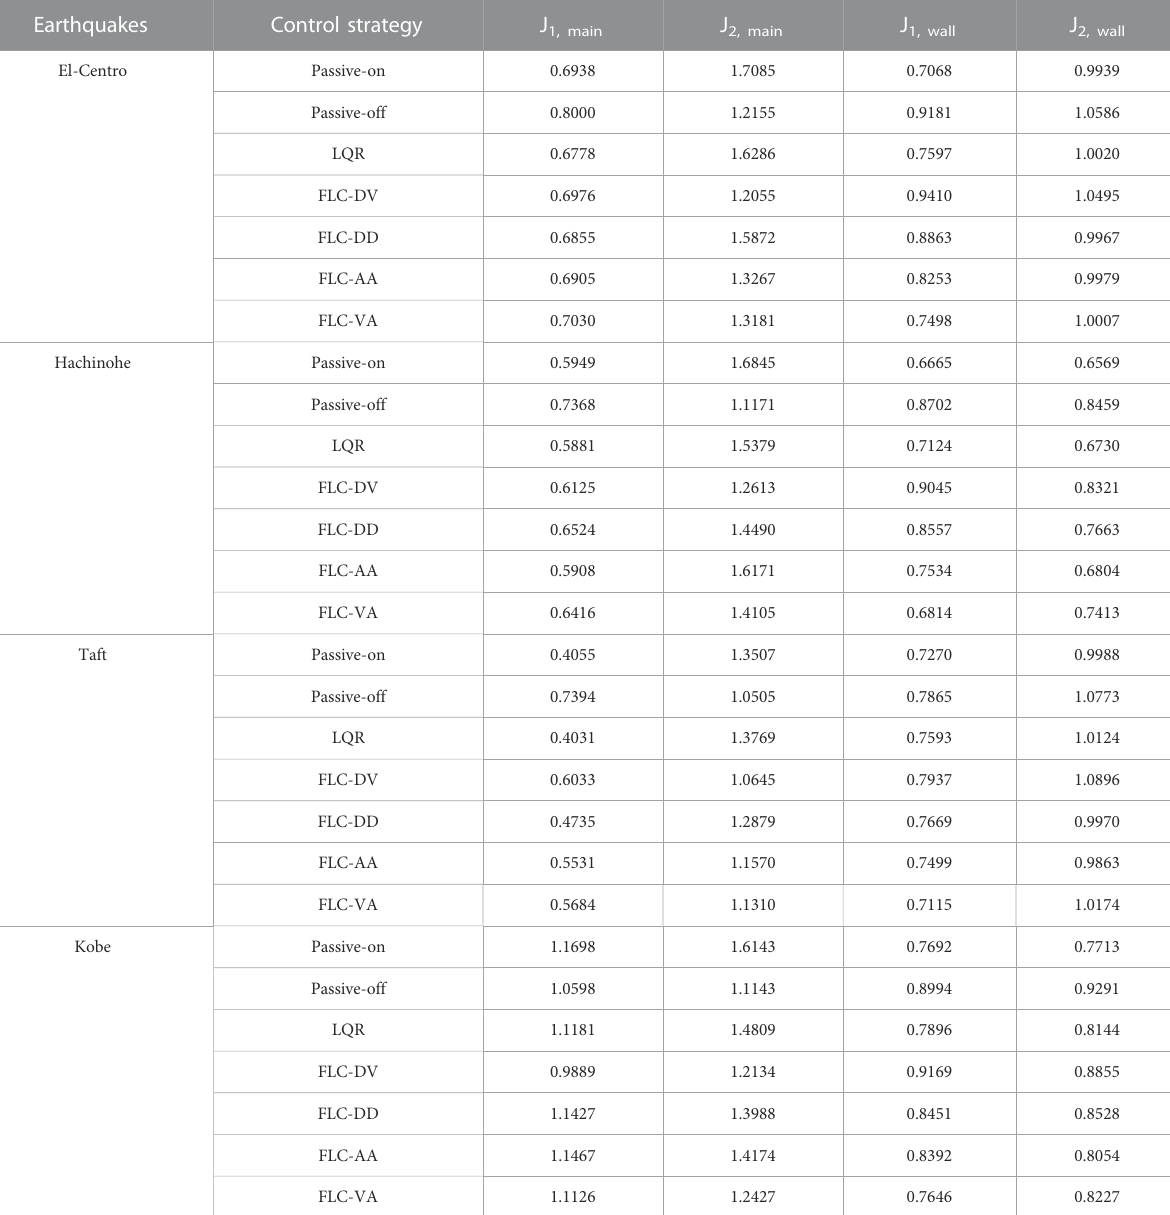
TABLE 2 Evaluation criteria of each building.